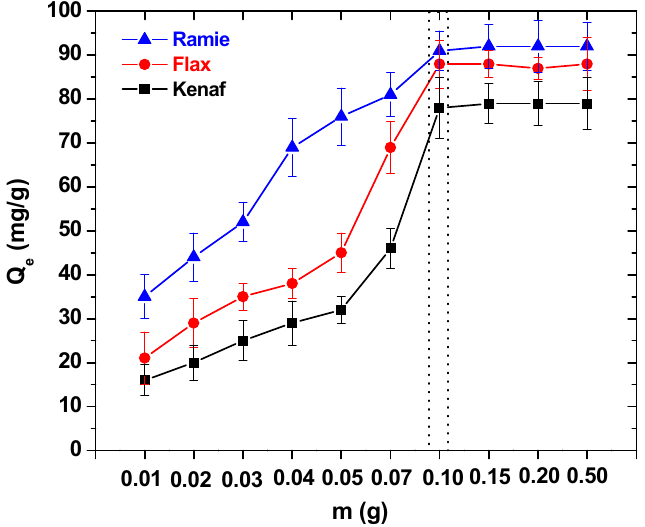
Figure 8. Effect of the adsorbent’s mass for the removal of BY37 by adsorption onto flax, kenaf, and ramie fibers (adsorption conditions: C 0 = 100 mg·L − 1 , pH = 12, T = 25 °C, N = 160 rpm, m = 0.01–0.5 g, V = 100 mL, and t = 24 h)